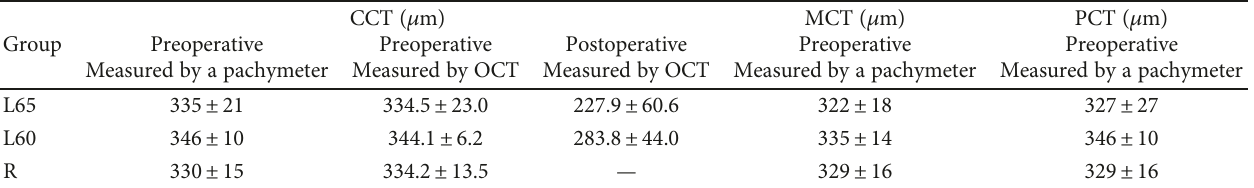
Table 1: Corneal thickness for each